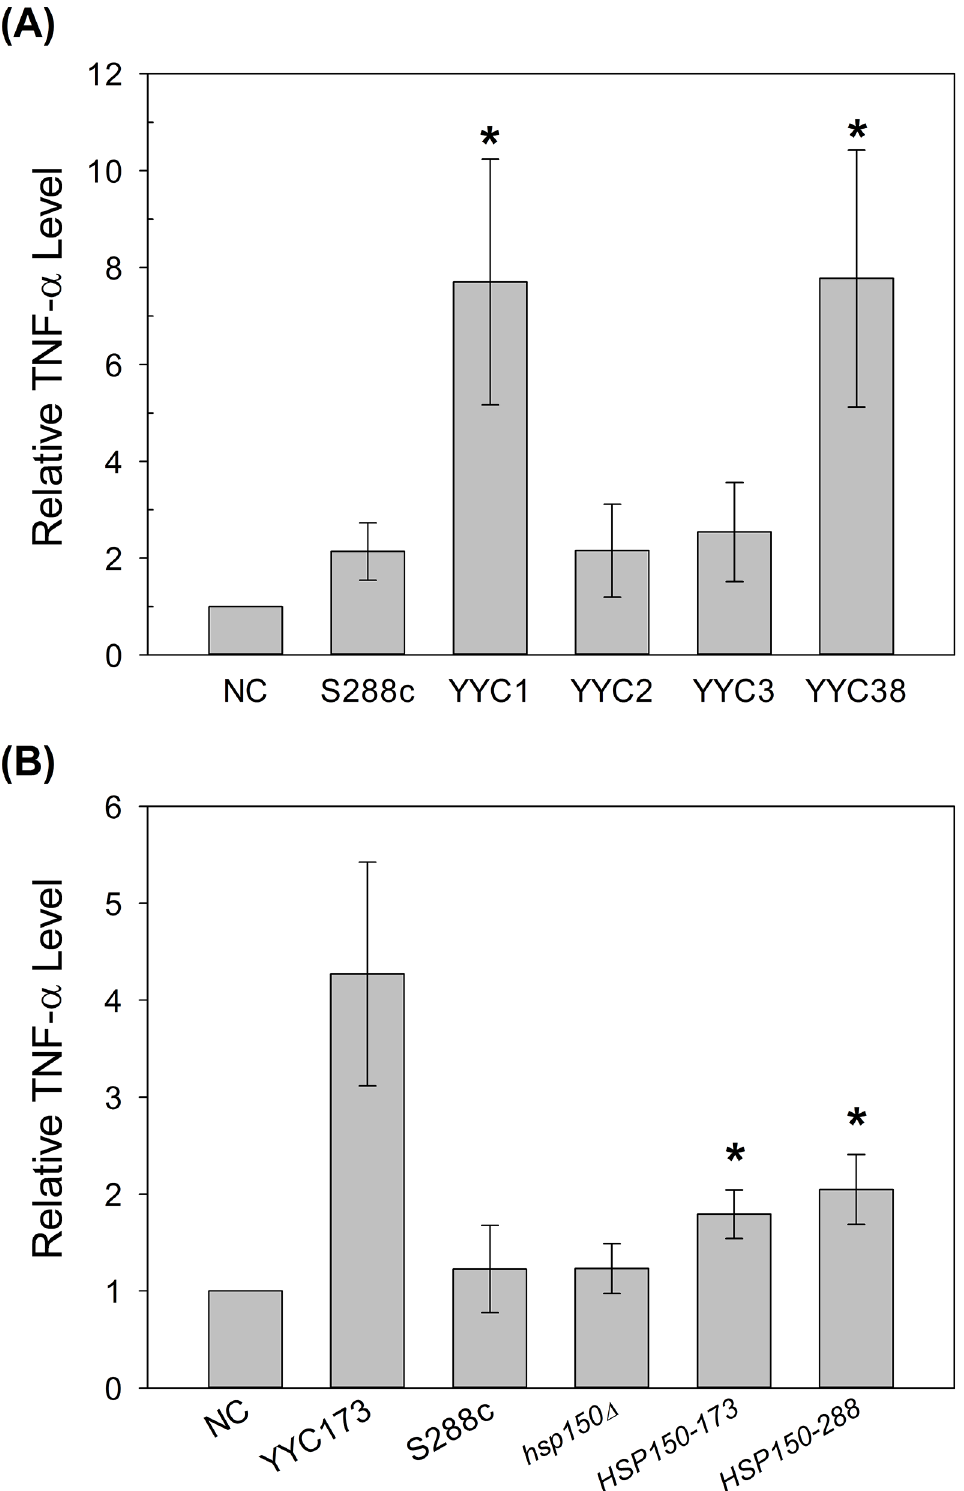
Fig 6. Overexpression of Hsp150p elicits greater proinflammatory cytokine TNF- α induction in macrophage cell line. Murine macrophage cell line RAW264.7 was exposed to clinical isolates (A), and YYC173, hsp150 Δ strain containing the control vector, overexpressed the allele HSP150-288 , or allele HSP150-173 (B) as indicated. NC, macrophage treated without any yeast cells. 2 or 3 biological replicates were performed. Asterisks indicate statistically significant differences from S288c (A) or hsp150 Δ (B) ( p < 0.05). doi:10.1371/journal.pone.0135174.g006 PLOS ONE | DOI:10.1371/journal.pone.0135174 August 13,